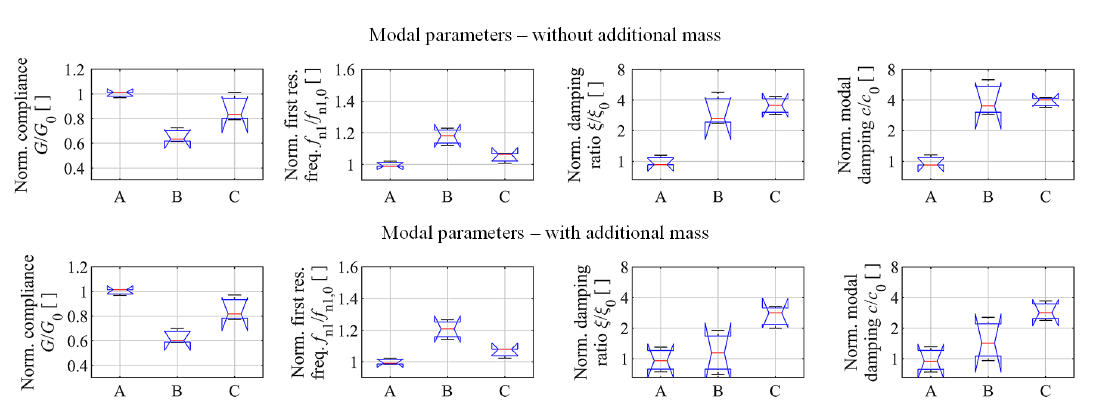
Figure 5. Specimens’ modal